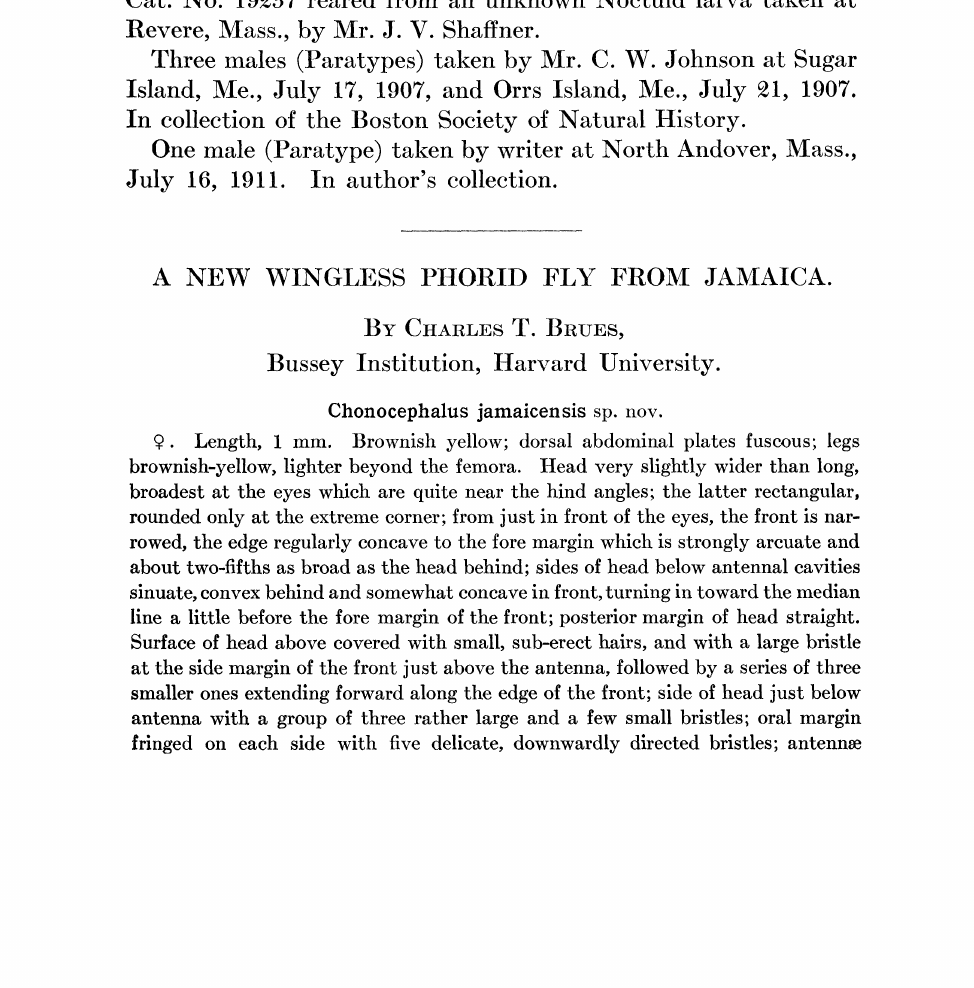
Psyche [June Middle tibiae each bearing two or more macrochetm on the front side near the mid- dle. Hind tibiae sub-ciliate. Abdomen black, the segments grayish pollinose on the basal four-fifths, with the exception of the first segment, which is destitute of pollen on the dorsum. A median black dorsal vitta. First and second segments bearing a pair of median marginal macrochete, the third a marginal row and the fourth bearing macrochete on its apical two-thirds. Hairs of abdomen sub-erect. Wings hyaline. Apical cell open, ending before the wing tip. The third longitudi- nal vein bearing two or three bristles at its base. Calypteres whitish, faintly bor- dered with yellowish. Puparium 7 mm. in length. The anal stigmata highly raised, sub-cylindrical, nearly .5 ram. long. Reticulations in three distinct half circular impressions with a small circular impression in the